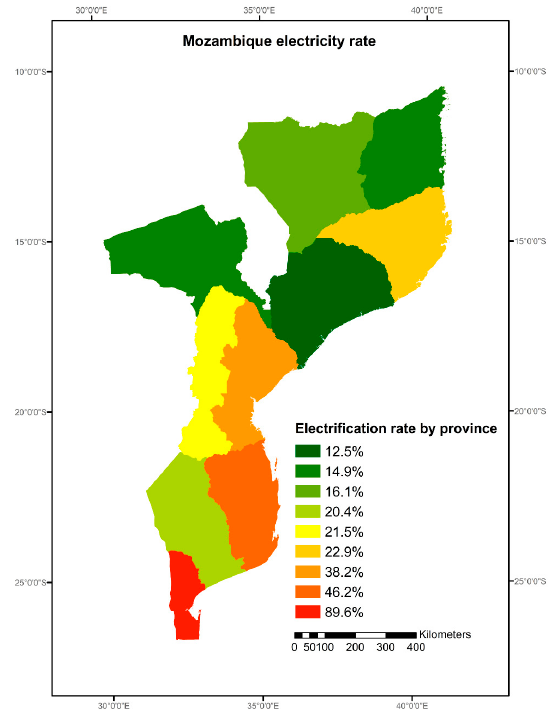
Figure 1. Mozambique electricity rate in 2020. Data from [8].